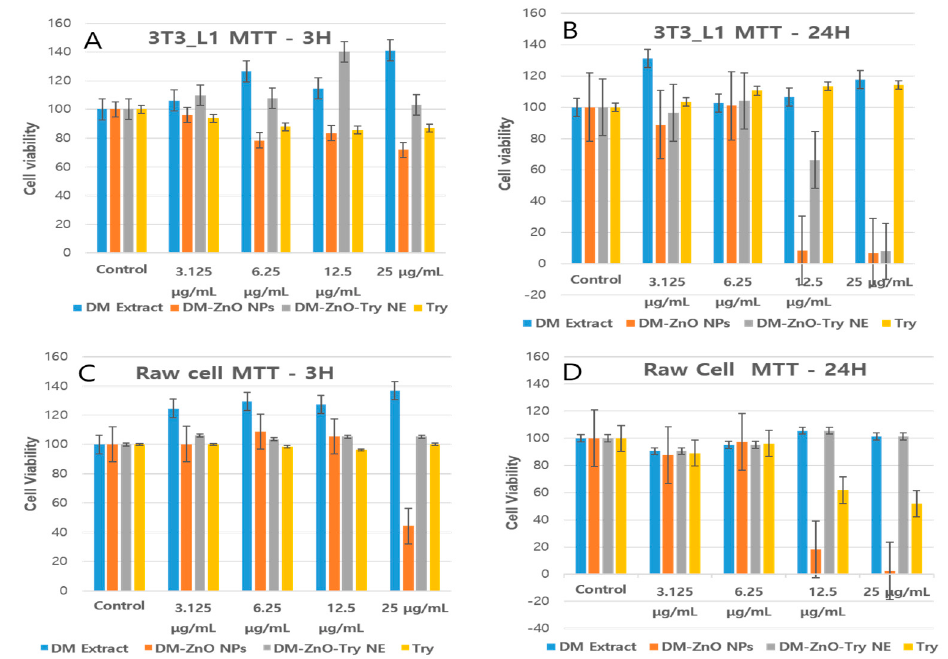
Figure 8. In vitro cytotoxicity analysis for DM extract, DM-ZnO-NPs and DM-ZnO-Try-NE, and Try in 3T3-L1 cell line ( A ) 3 h and ( B ) 24 h and raw cell line ( C ) 3 h and ( D ) 24 h. Each value is expressed as the mean ± standard error of three independent experiments. p < 0.001 compared with control.